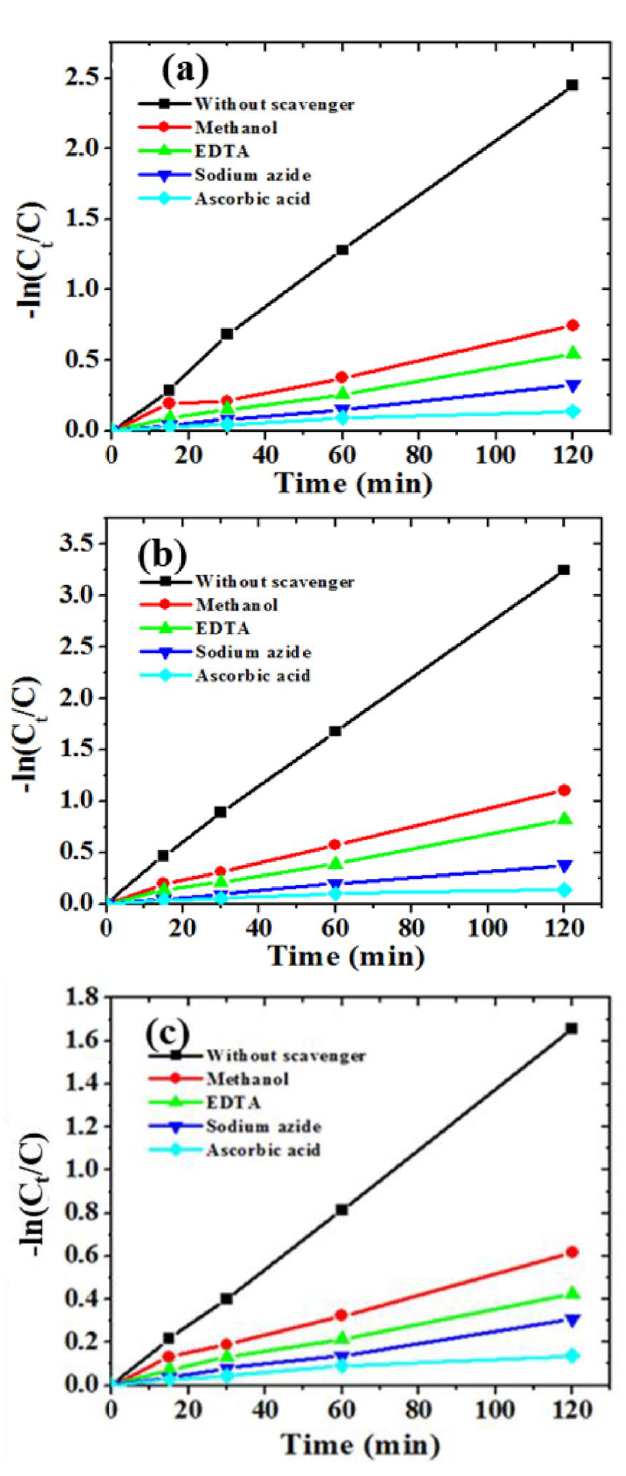
Figure 11. Kinetic studies of inhibition of degradation of ( a ) p -nitrophenol, ( b ) pendimethalin and ( c ) Martius yellow. Experimental conditions: pH, 3.0; catalyst dose, 0.2 g/L ( p -nitrophenol, pendimethalin) and 0.4 g/L (Martius yellow) and concentration 0.5 mg/L ( p -nitrophenol and pendimethalin) and 0.05 mg/L (Martius